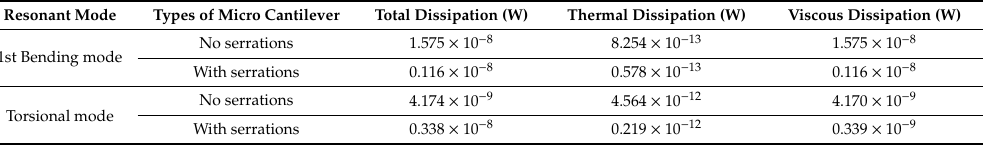
Table 5. Viscous and Thermal Dissipation of studied MCL